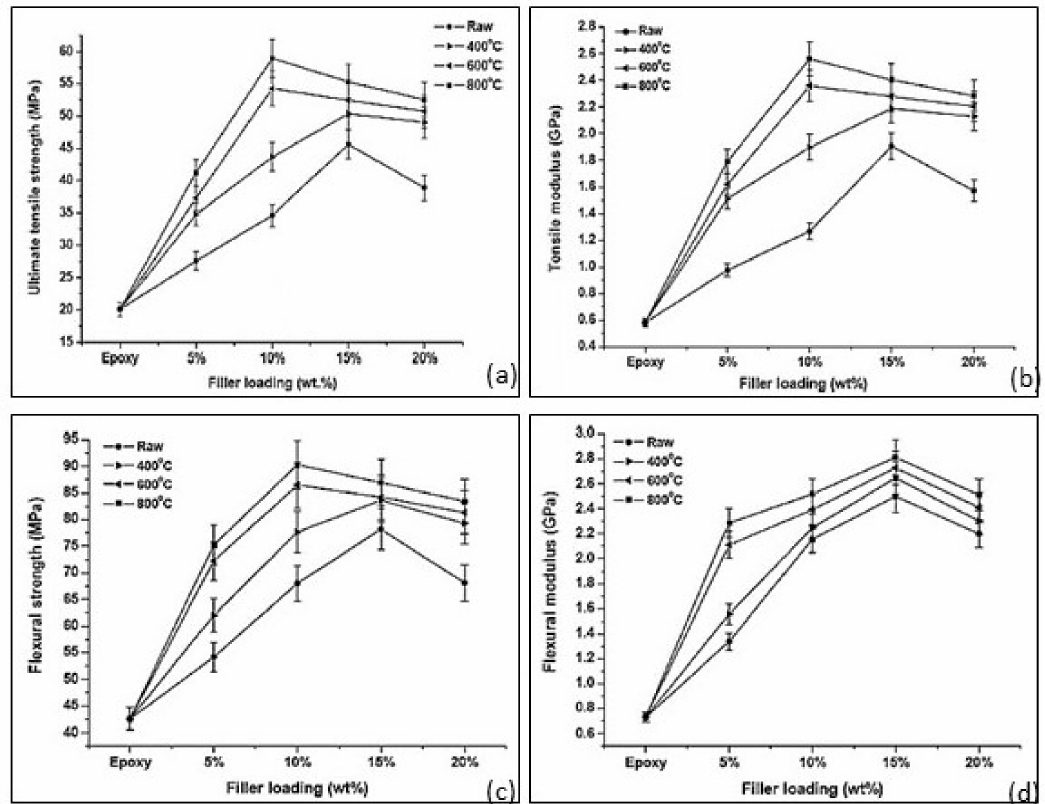
Figure 19. Effect of filler loading and carbonization temperature of composites on ( a ) ultimate tensile strength, ( b ) tensile modulus, ( c ) flexural strength, and ( d ) flexural modulus